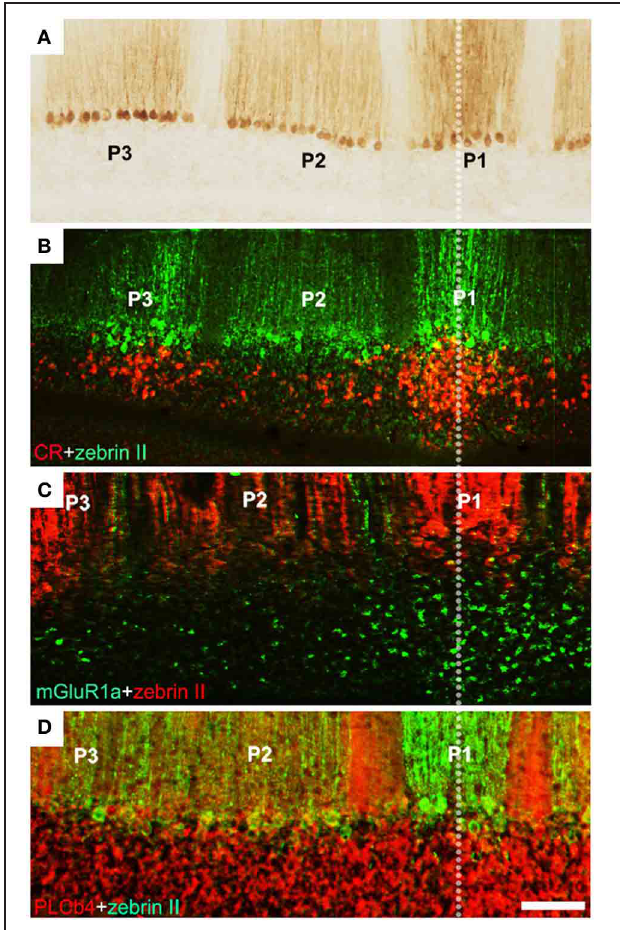
FIGURE 4 | Unipolar brush cells are restricted at stripe boundaries in the adult mouse cerebellum. (A) Cerebellar stripe topography is built around PC subtypes. Immunoperoxidase staining of a transverse section through lobule IX for zebrin II reveals three broad stripes of immunoreactive PCs [P1 + at the midline, P2 + and P3 + laterally on either side: for stripe nomenclature, see Sillitoe and Hawkes (2002)]. (B) CR + UBC clusters (red) in lobule IX align with the zebrin II P1 + and P3 + PC stripes (green). (C) mGluR1 α + UBCs (green) in lobule IX cluster beneath the midline P1 + PC stripe (red). (D) Double immunostaining with anti-PLC β 4 (red) and anti-zebrin II (green) shows that PLC β 4-immunopositive UBCs are uniformly distributed in cerebellar lobule IX (the combined PLC β 4 + and mGluR1 α + subsets). Scale bars: D = 125 μ m (A–D) [Adapted from Chung et al.